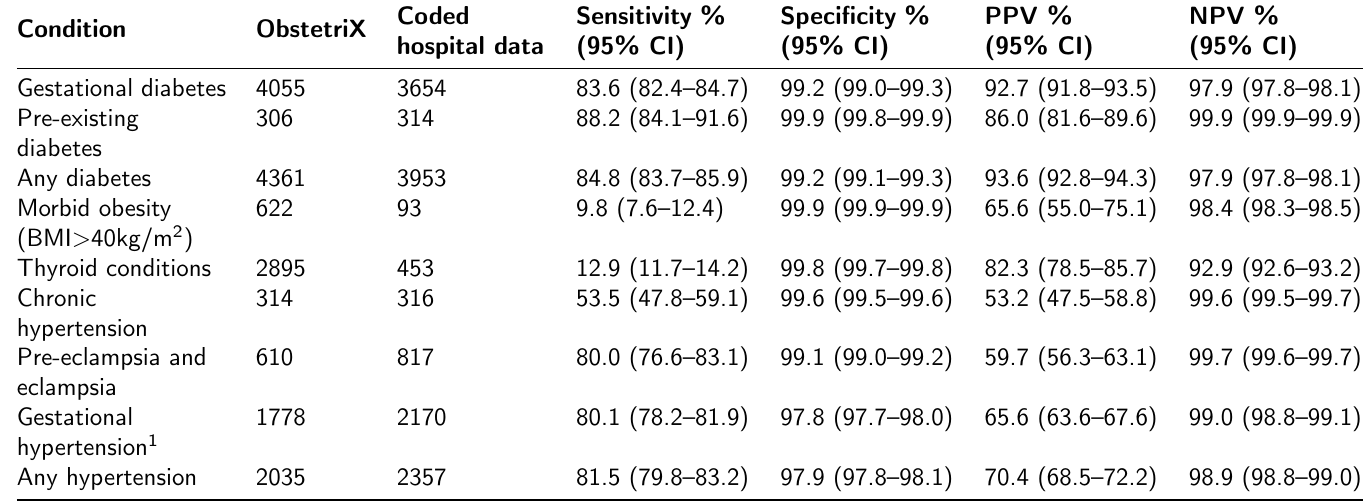
Table 1: Reporting consistency between ICD10-coded hospital and ObstetriX datasets across two tertiary hospitals in New South Wales, 2011–2015, with ObstetriX as the reference